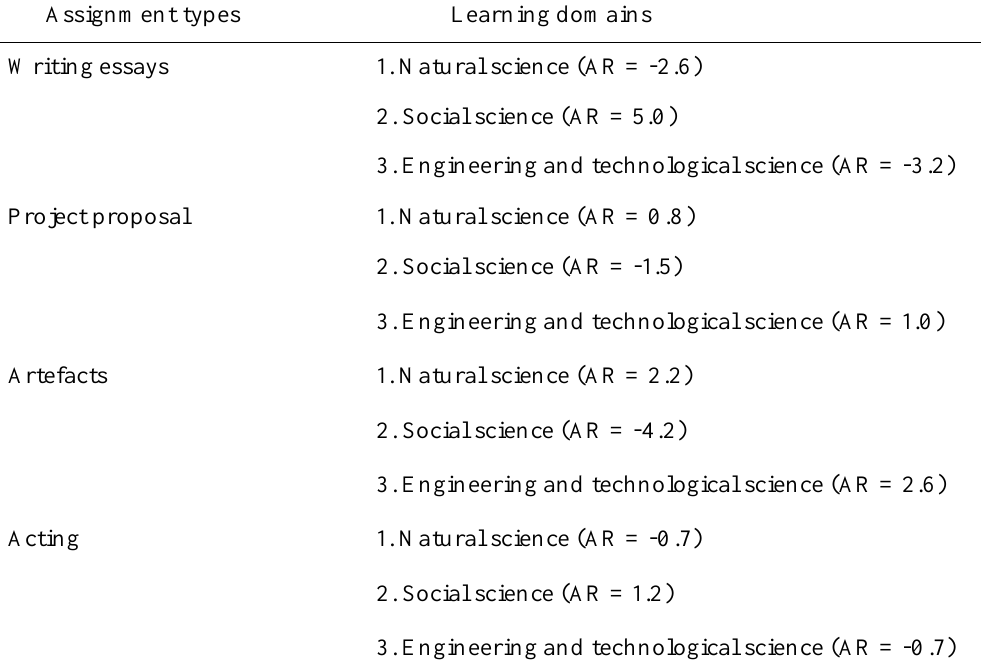
Relationships Between Assignment Types and Learning